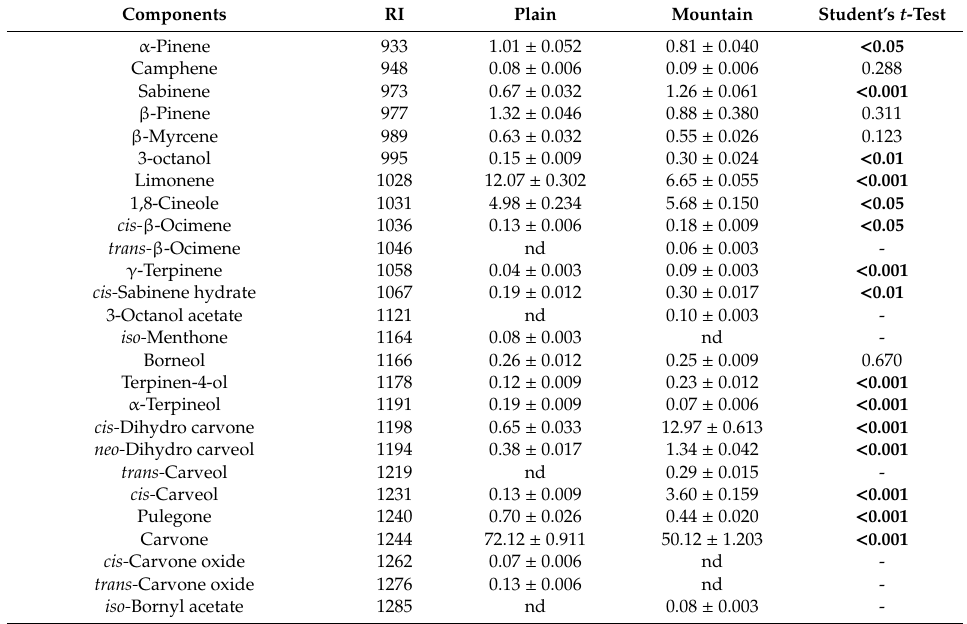
Table 10. Chemical composition (%) of essential oils of spearmint plants grown at di ff erent altitudes (plain vs. mountain). Data are expressed as means ± SE (n = 3), and significant di ff erences ( p < 0.05, p < 0.01, p < 0.001) in bold between treatments are indicated by Student’s t -test p